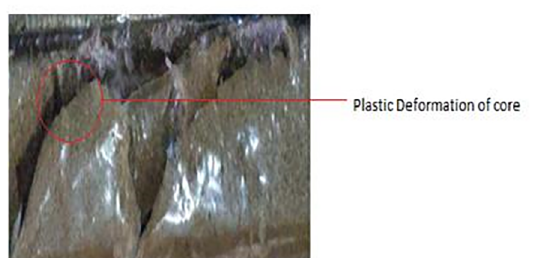
Figure 11. Unstitched specimen.